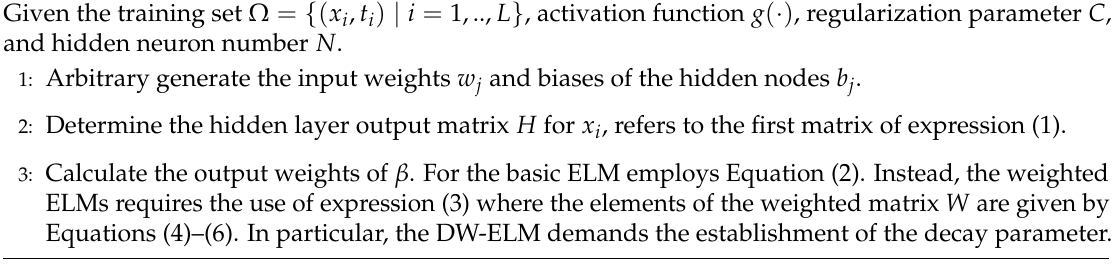
Algorithm 1 ELM learning